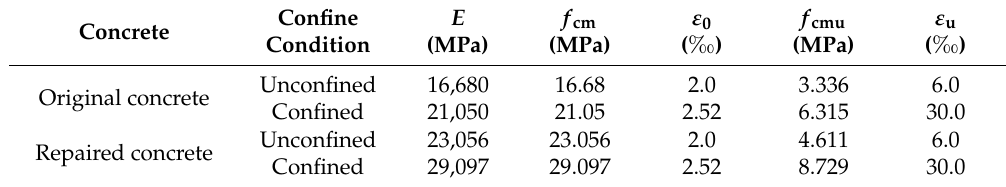
Table 7. Concrete mechanical properties adopted in the numerical model (unconfined and confined).